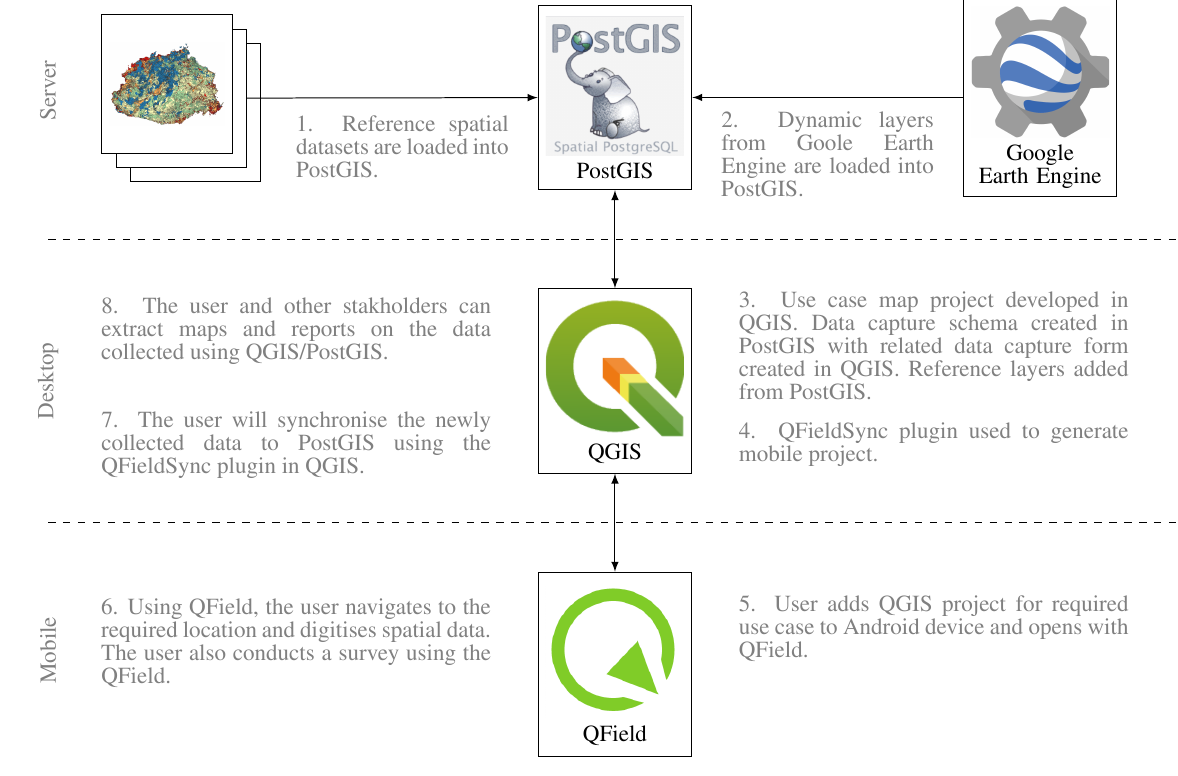
Figure 4. Conceptual design of the pilot tool, and a generic use case of the tool (numbered 1 to